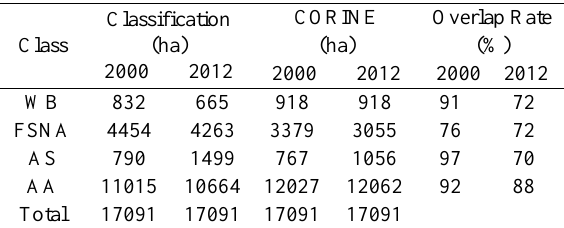
Table 5. The comparison results for generalization